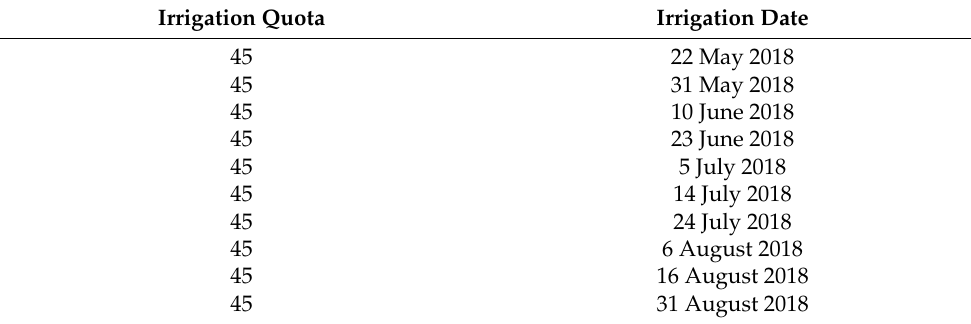
Table 1. Irrigation quota and irrigation date.